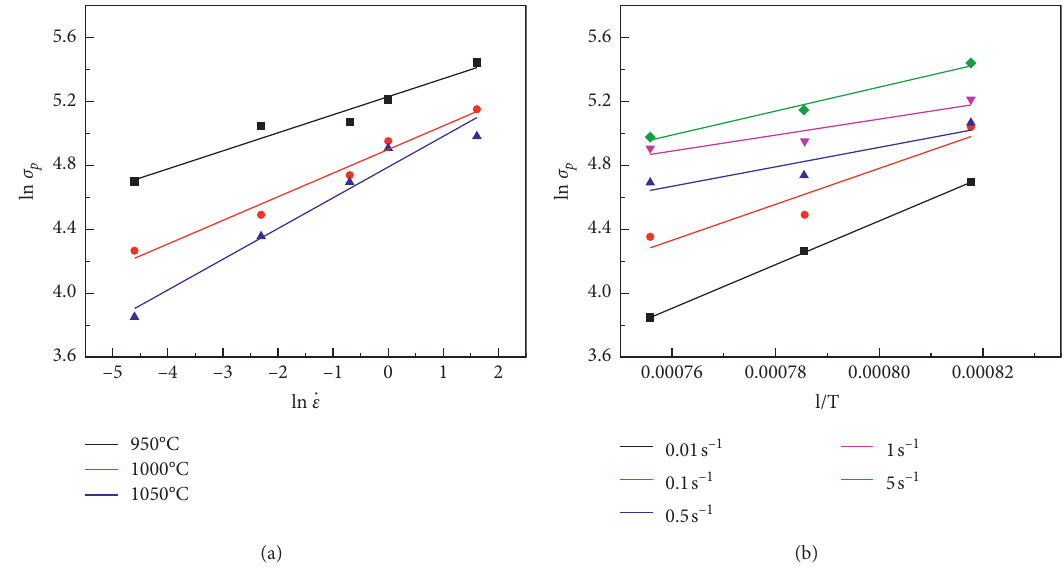
Figure 6: Plots of ln σ _ ε (a) and ln σ p vs. ln p vs. 1/ T (b). Table 1: The value of n ′ fitted at different strain rates and temperatures.